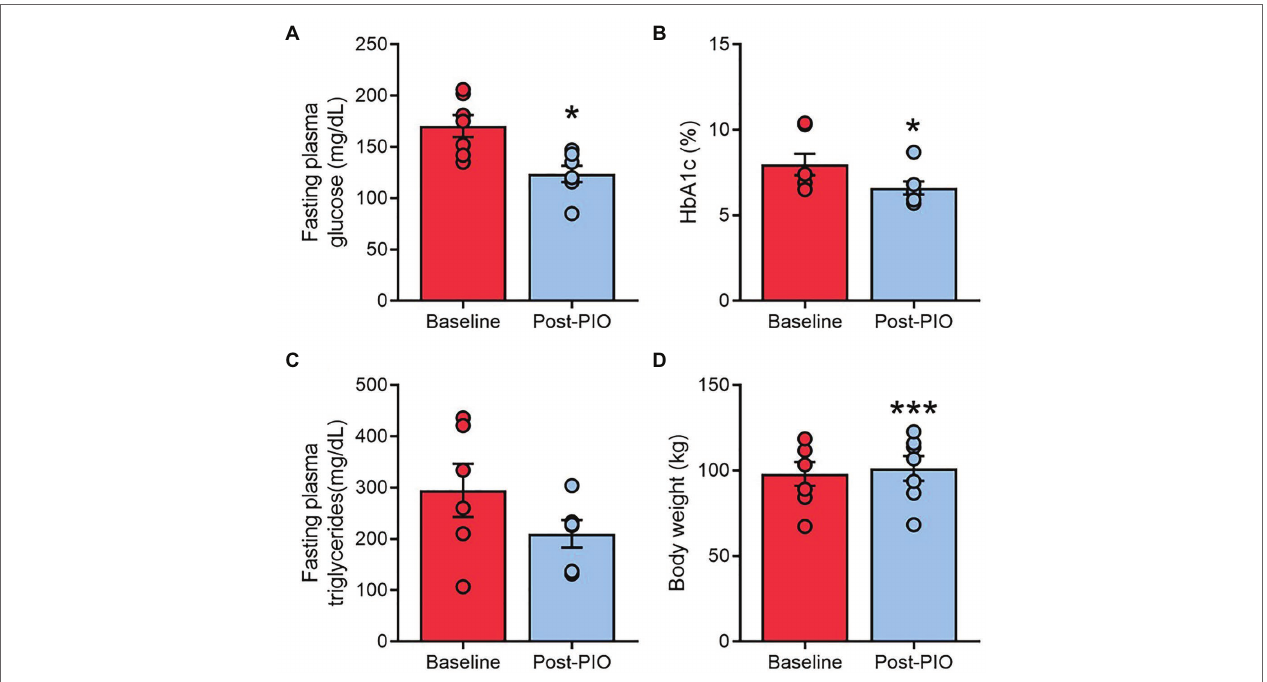
FIGURE 1 | Clinical responses to pioglitazone treatment. Fasting plasma glucose (A) , glycated hemoglobin (B) , plasma triglycerides (C) , and body weight (D) at Baseline (red) and following 6 months of 45 mg/day pioglitazone treatment (blue). * p < 0.05, *** p < 0.001 vs. Baseline. Data are mean ± standard error (filled bars) and individual values (filled circles) for n = 7